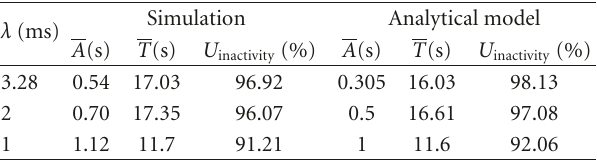
Table 2: Analytical model versus